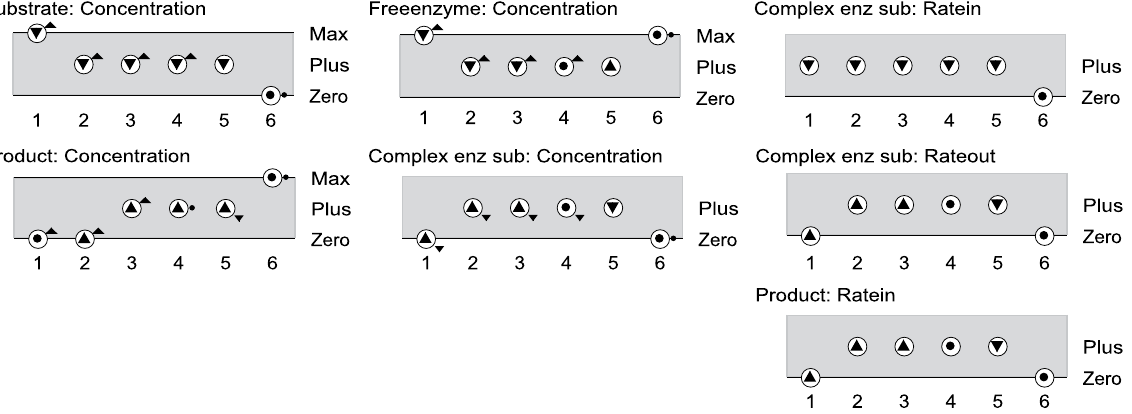
Figure 4. Value history for quantities in the states selected in Fig. 3. “X-axis” refers to the state labels (numbers) in the state-graph. Possible values (as defined by the QS) are listed on the right-hand side of each quantity history. The small circles depicted above each state label denote the current value of a quantity. The tendencies are shown within those circles, one of { ▼ , Ø, ▲ }. For instance, in state 5, Product Concentration has current value Plus , is increasing ( ∂ = ▲ ), and slowing down ( ∂′ = ▼ , 2 nd order tendency shown next to circle).